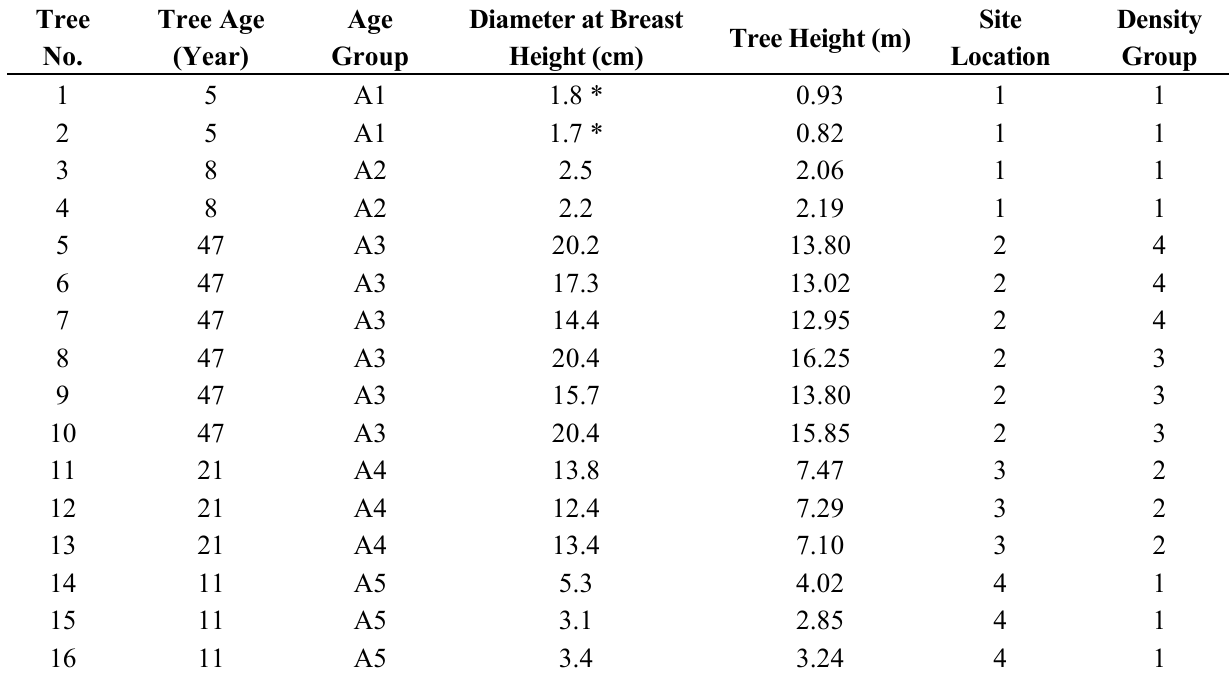
Table 1. Description of 16 sampled Chinese pine